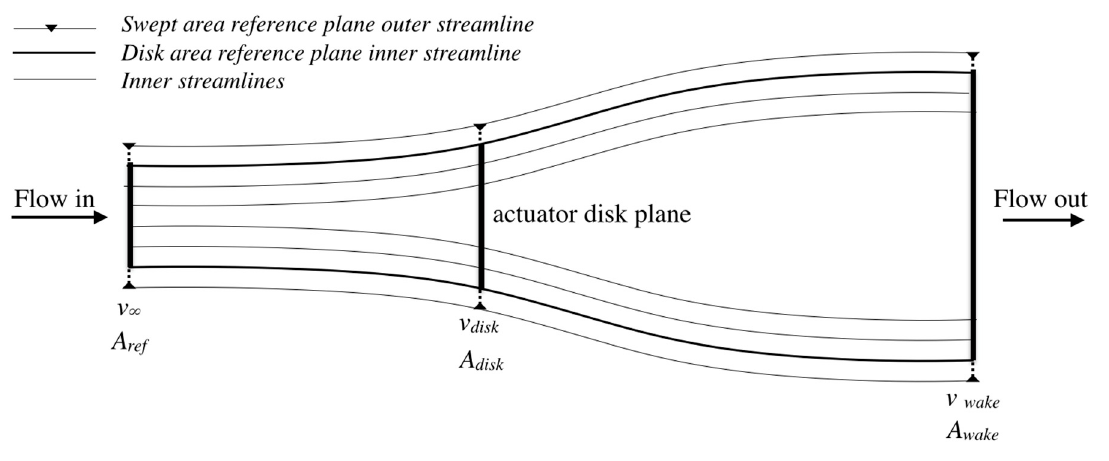
Figure 4. Betz Figure 4. Betz streamlines.